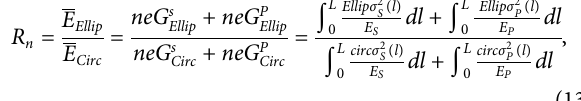
( Figure 15A ). Comparing the stress curves from the patched side, the curve (solid triangles) of the EA-patched sample is much fl atter than the CA counterpart (solid circles), which suggests the EA patch has more ef fi ciency in reducing the local stress concentration. The tensile stress along the longitudinal axis of the notched coupons and patches (vertical red lines sketched on the sample and patches) on the contacted surfaces of the EA and CA patch – reinforced samples is extracted along with and without the nominal elastic energy along the axes ( Figure 17 ).